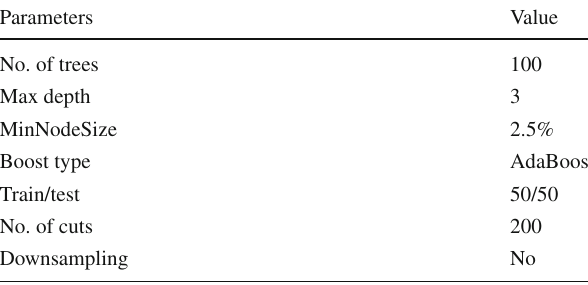
Table 4 BDT parameters used for the truth and reco data set Parameters